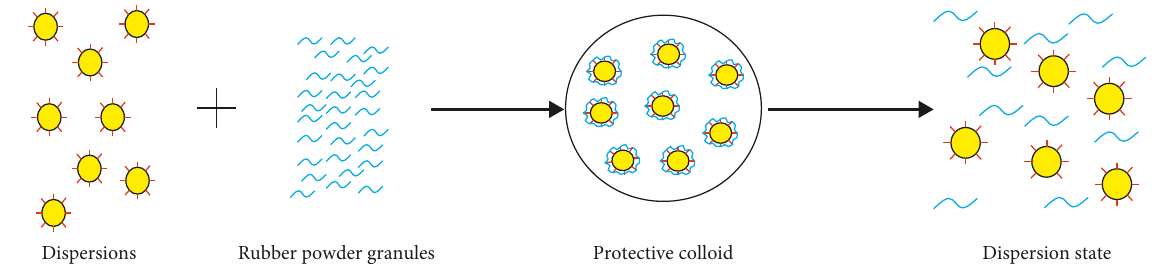
Figure 1: Preparation and properties of the adhesive Table 1: Performance requirements of the paste with the accelerator and hardened mortar.